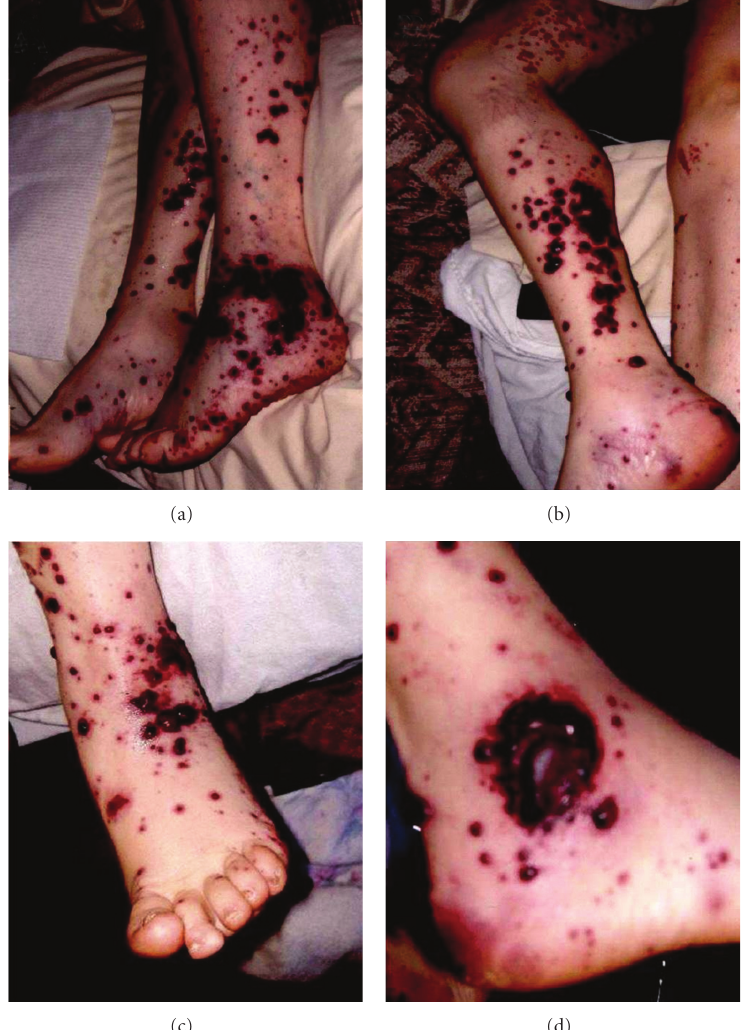
Figure 1: Photographs of the vasculitic lesions on the lateral (a), posterior (b), and anterior aspects of the legs. Close-up of the large ulceration on the lateral malleolus